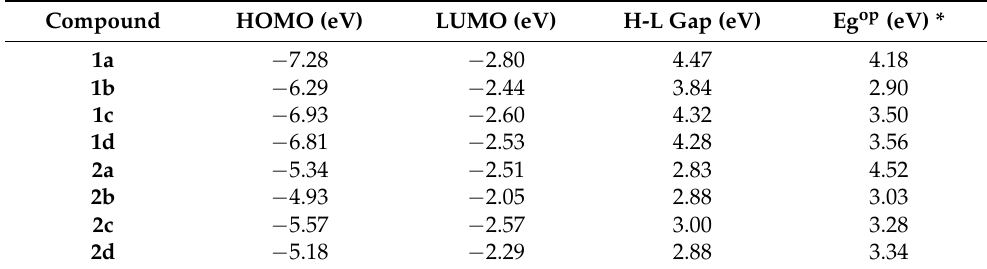
Table 5. HOMO-LUMO (H-L) gap values of compounds 1a – d and 2a – d . Data are calculated at aug-cc-pVDZ/PBE0 level of theory. Experimental Eg op values are also shown.